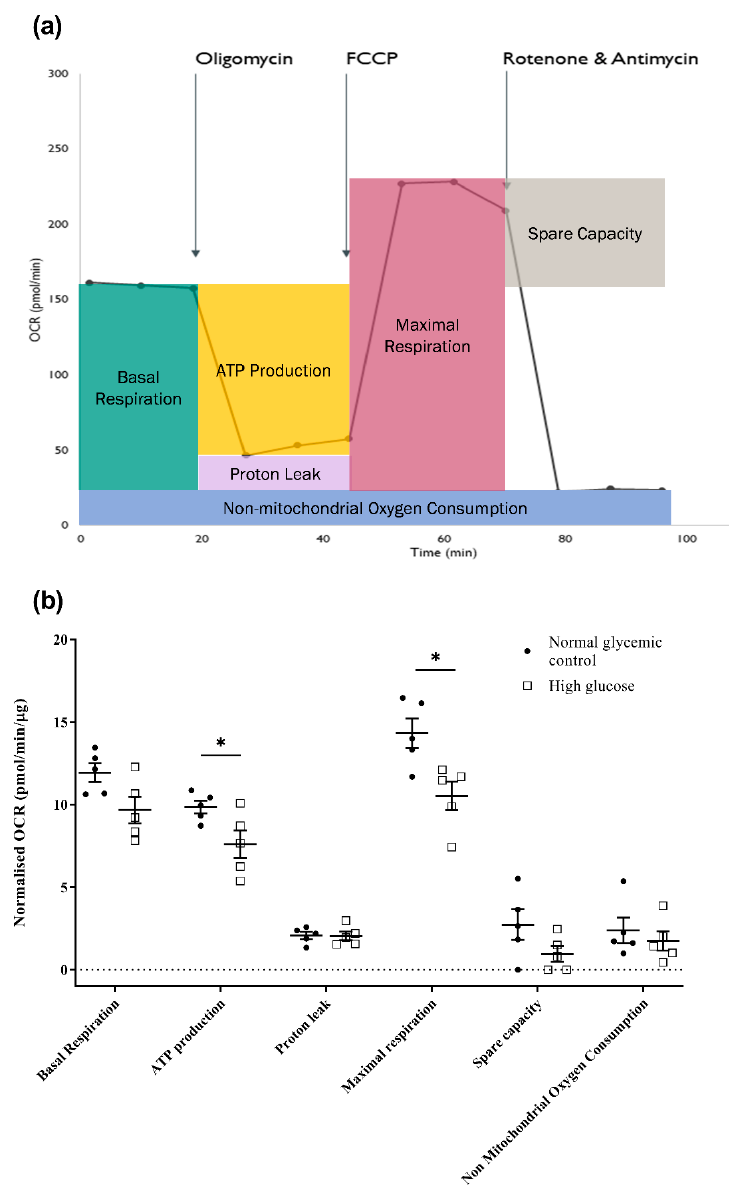
Figure 5. Effect of high glucose on mitochondrial bioenergetics of 661w cells. ( a ) Illustrative diagram of how key mitochondrial function parameters are divided from the Seahorse Mito Stress assay. The Seahorse XF analyzer first measures the oxygen consumption rate (OCR) as the basal respiration of the cells, and the rate of mitochondrial ATP synthesis can be estimated from the decline in OCR after adding oligomycin, an ATP synthase (complex V) inhibitor, with the remaining OCR representing the proton leak across the mitochondrial membrane in situ. The subsequent addition of an uncoupling agent, FCCP, collapses the proton gradient and disrupts the mitochondrial membrane potential, allowing the oxygen consumption of complex IV, the rate-limiting step of oxidative phosphorylation, to reach the maximum levels. This increase in OCR reflects the maximal respiration rate of the mitochondria, and the difference between the maximal respiration and basal respiration indicates the spare capacity of the mitochondria. Moreover, the injection of rotenone and antimycin A mixture ceases mitochondrial respiration, and the remaining OCR reveals the non-mitochondria-related usage of oxygen. ( b ) Dot plots showing the effect of high glucose on the key mitochondrial function parameters of 661w cells. (* p < 0.05. Data presented as means ± SEM. n = 5 (biological